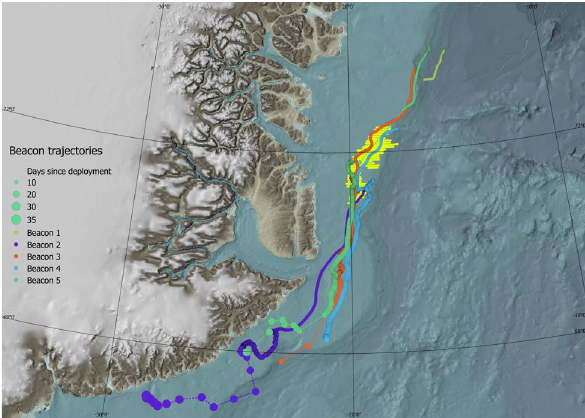
Figure 2. Trajectories of five GPS beacons deployed in the vicinity of the whelping grounds identified during helicopter and fixed wing reconnaissance surveys. Yellow lines represent transects during the aerial surveys carried out on March 27 and 28.